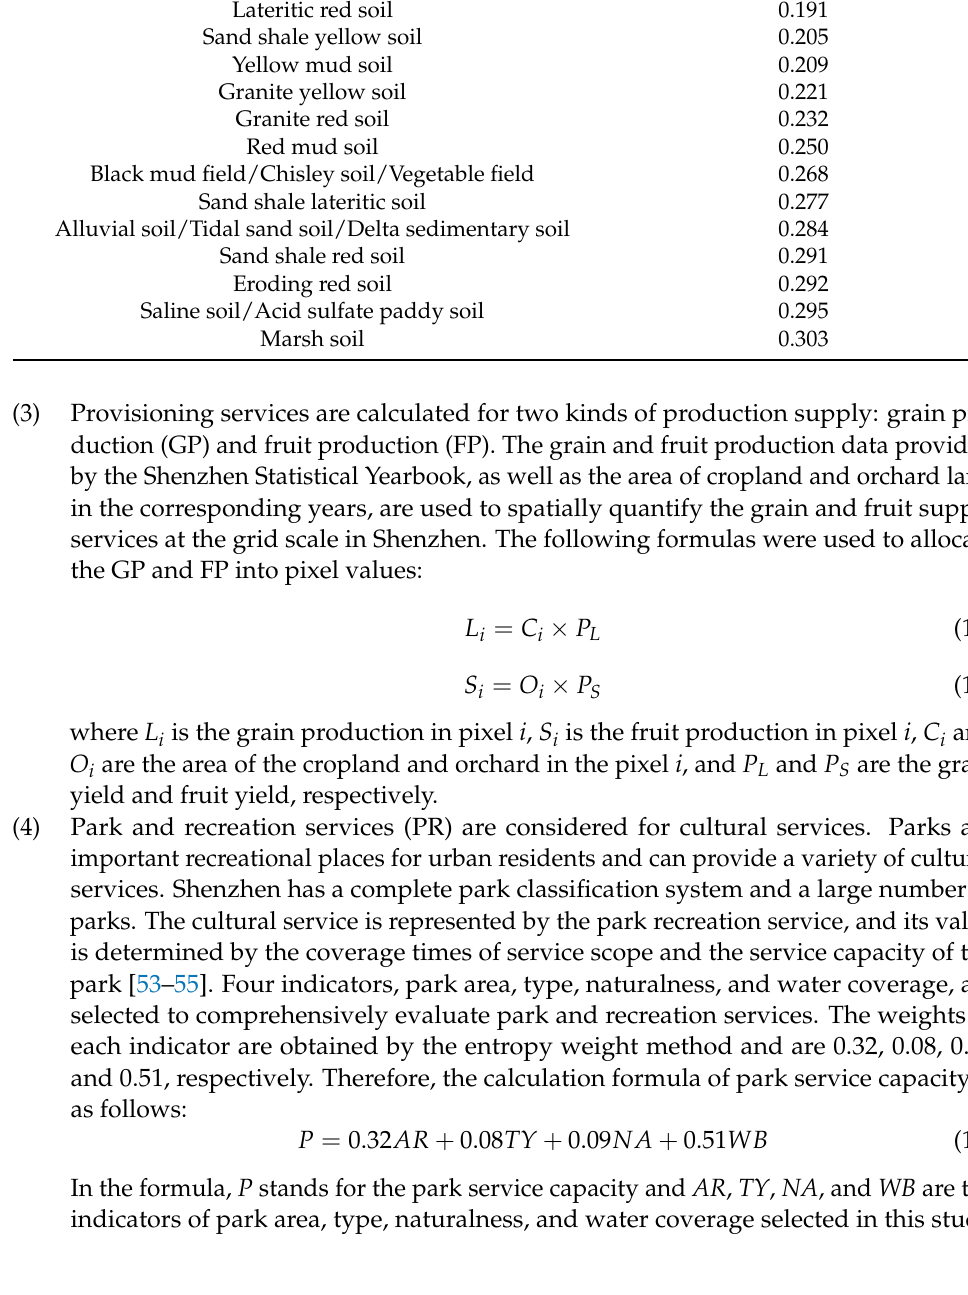
Table 3. K value based on the soil type map (Unit: t • hm 2 • h • hm − 2 • MJ − 1 • mm − 1 ). Soil Type K Value Coastal sandy field/mudflat